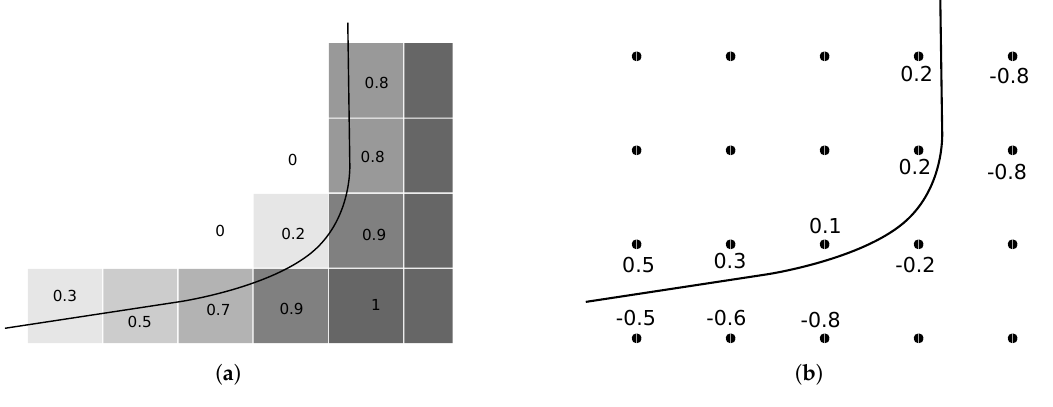
Figure 5. Comparison of cell-based and level set representations in narrow-band implementations. While the former is intrinsically associated with volume, level set representations describe an interface or boundary. ( a ) Cell-based representation of an explicit surface (black line) with numbers indicating the filling fraction of each cell. The darker a cell, the higher the filling fraction. ( b ) Level set representation of an explicit surface (black line) with level set values, related to the normal distance from the surface, for each grid